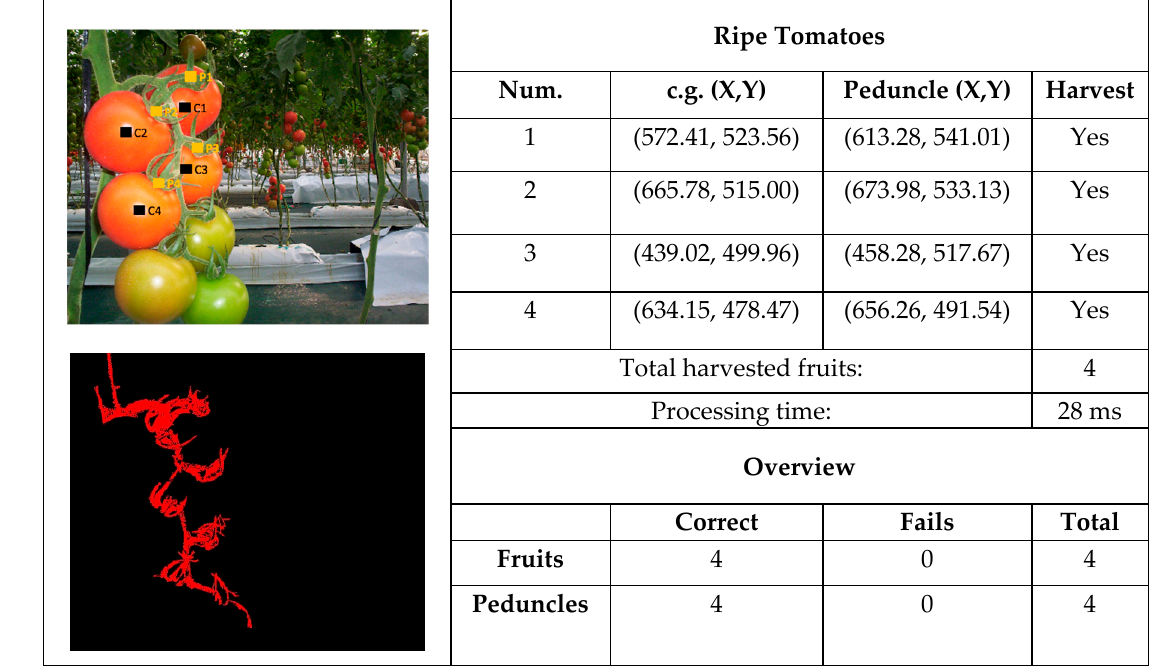
Figure 22. Convex area centers, peduncle detection and results.